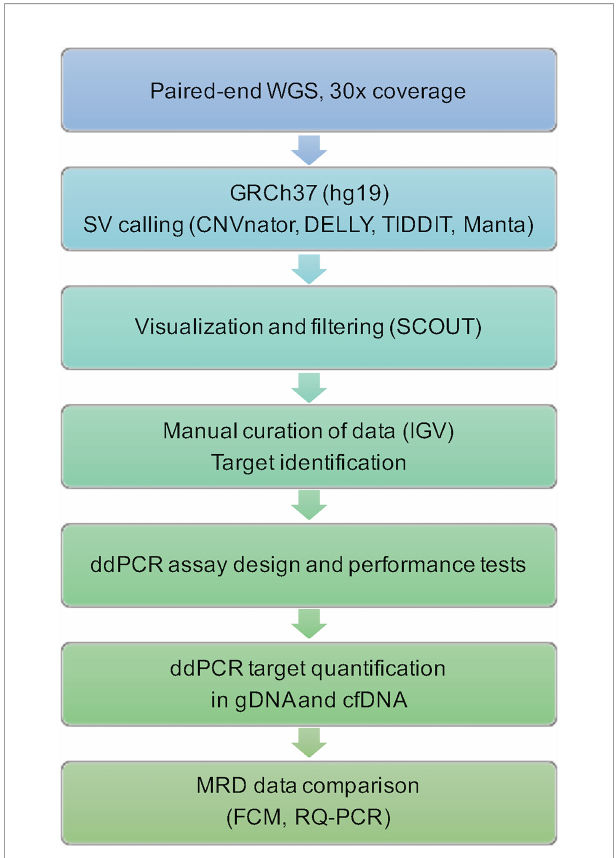
FIGURE 1 | Flowchart of steps and techniques used for identi fi cation and quanti fi cation of leukemic targets. WGS, whole-genome sequencing; GRCh37, Genome Reference Consortium Human Build 37; SV, structural variant; IGV, The Integrative Genomics Viewer; ddPCR, droplet digital PCR; gDNA, genomic DNA; cfDNA, cell-free DNA; MRD, measurable residual disease; FCM, fl ow cytometry; RQ-PCR, real-time quantitative